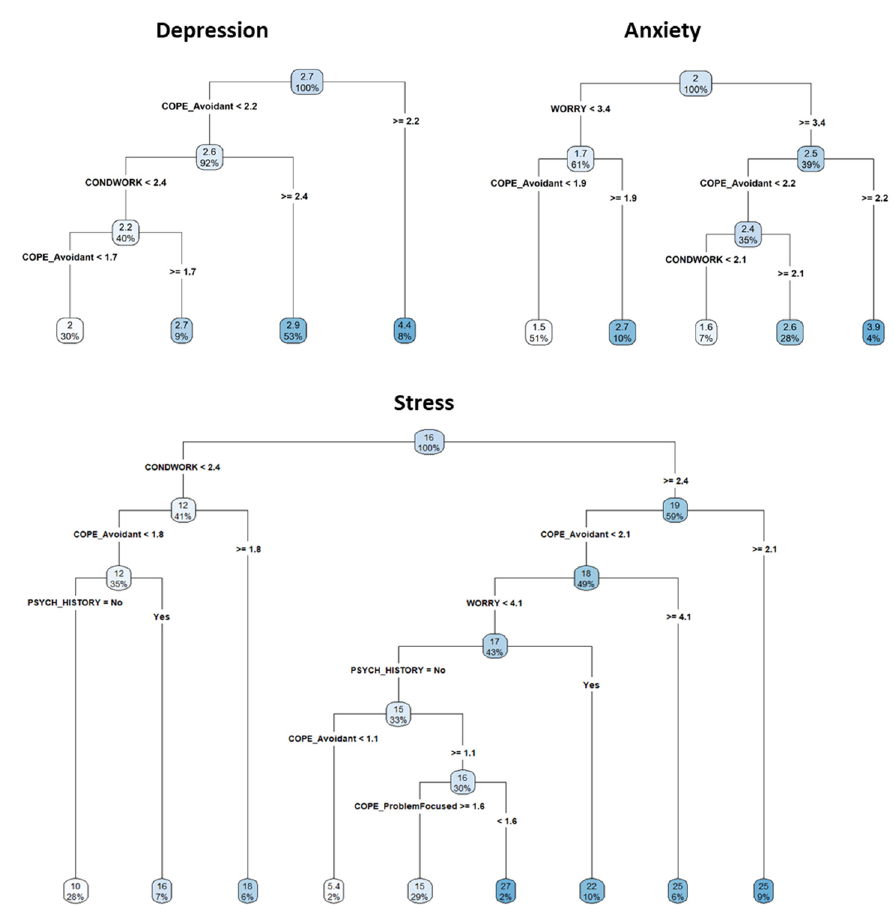
Figure 2. RE-EM tree for the DASS-21 subscales. Depression and anxiety scales were square root transformed. Each tree represents a series of splits starting at the top of the tree. Starting from the top node, a series of questions are presented based on the splitting variables and corresponding cut-off values. Depending on the answer, other branches may appear until the final node, which displays the average predicted outcome value for participants, satisfying all the conditions, leading to that node and the proportion of subjects falling in the node itself. For example, in the first tree for the depression scale, the top split assigns observations having avoidant coping scores greater than or equal to 2.2 to the right branch. The predicted depression level for these subjects is given by the mean response value for the individuals in the data set with avoidant coping ≥ 2.2. For such subjects, the mean depression level is 4.4. Among subjects who have avoidant coping scores < 2.2, the working conditions also affect depression level. For subjects with avoidant coping score < 2.2 and working conditions ≥ 2.4, the predicted depression level is 2.9. For subjects having working conditions < 2.4 and avoidant coping scores between 1.7 and 2.2, the predicted depression level is 2.7, whereas for subjects having a working conditions score < 2.4 and avoidant coping scores lower than 1.7, the predicted depression level is 2. The same logic applies to all the other trees. Abbreviation: CONDWORK, working conditions; Psych History, psychiatric history.